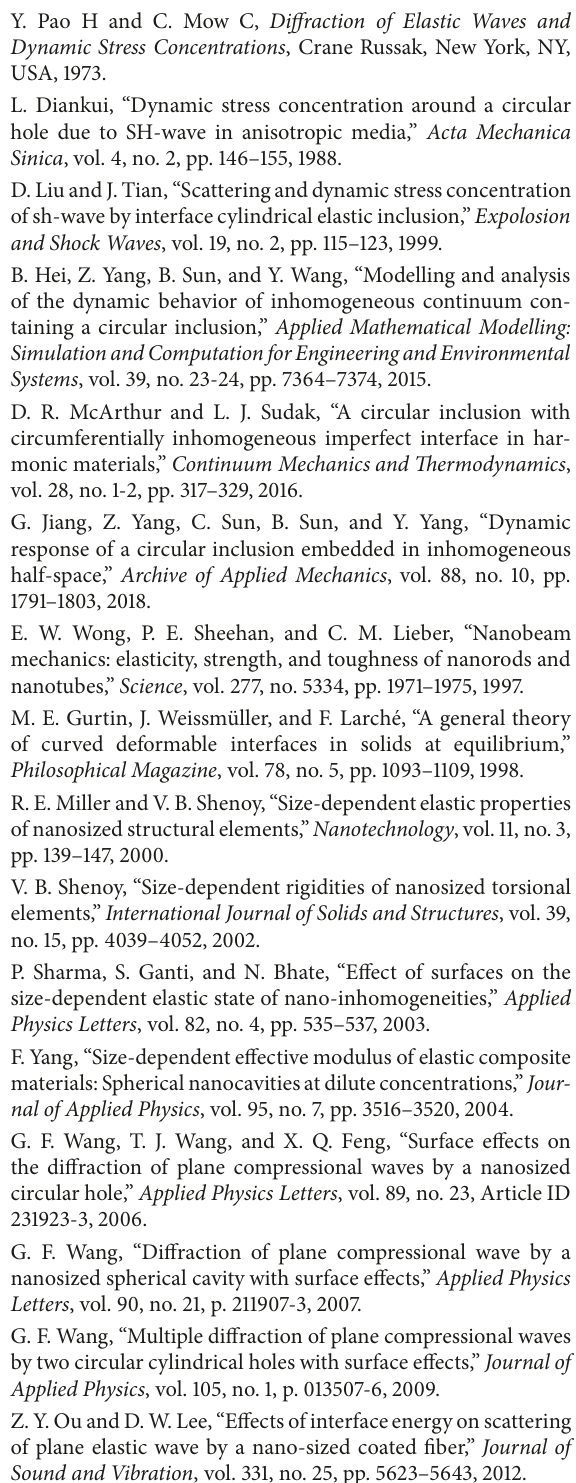
Figure 11: Effect of 𝜇 𝐼 /𝜇 on the radial stress with 𝐾 𝐼 /𝐾 = 𝜋 .